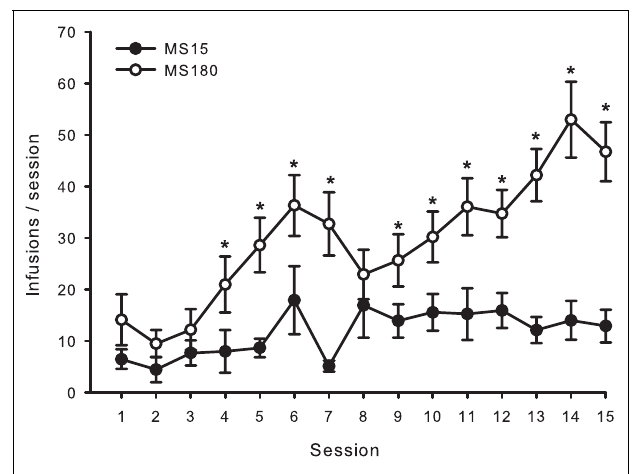
FIGURE 1 |Average number of METH SA infusions per 2-h session for 15 consecutive days in MS15 ( n = 9) and MS180 ( n = 17) rats . Data points represent group mean ± SEM. * p < 0.05 vs. MS15.